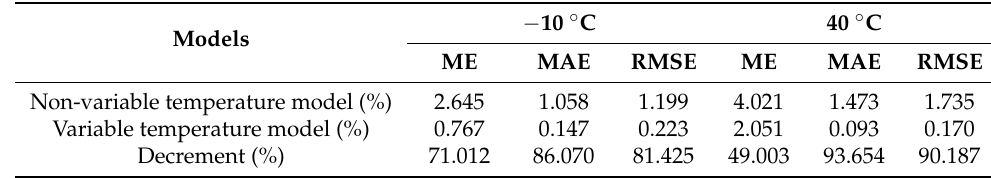
Table 5. The SOC error statistical results of two models between estimated and referred values at − 10 ◦ C and 40 ◦